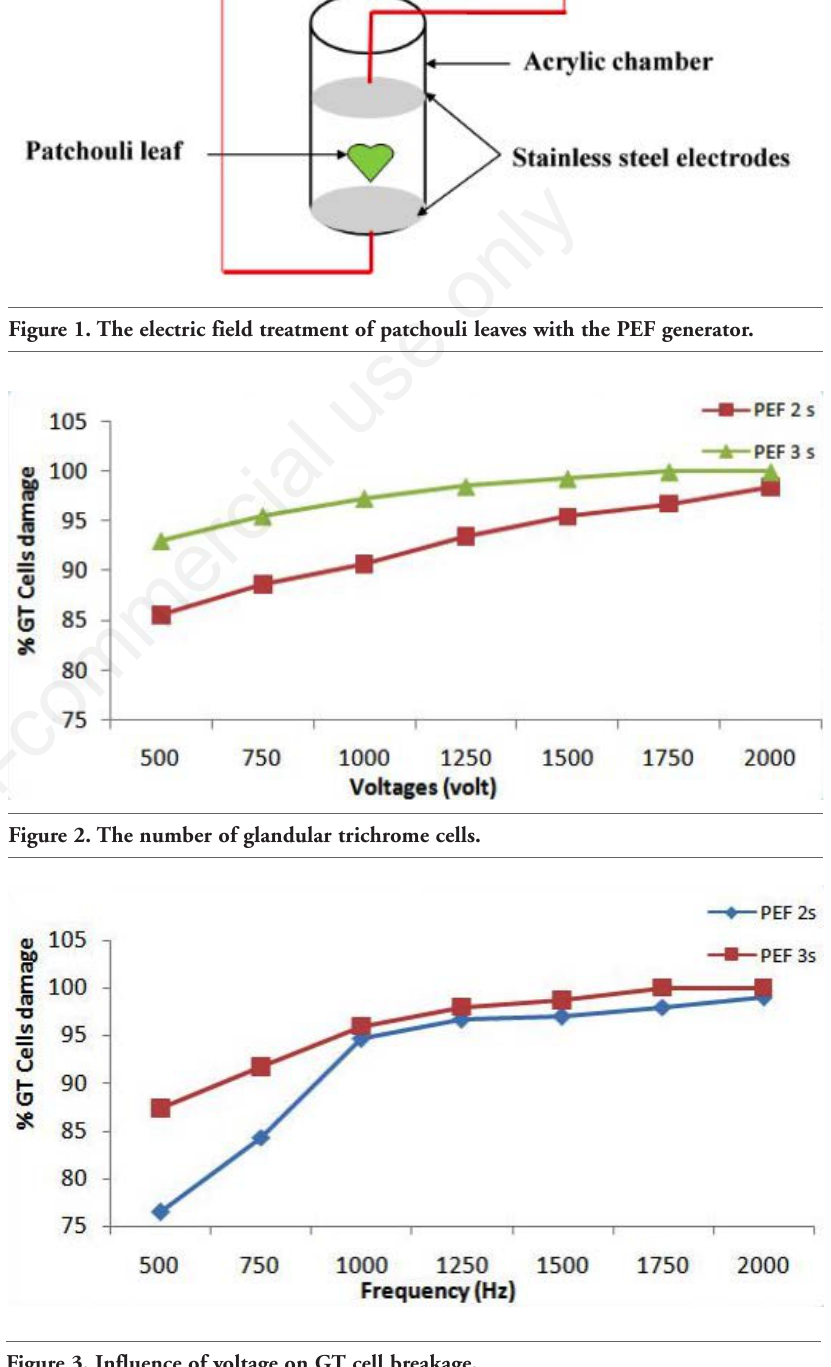
Figure 3. Influence of voltage on GT cell